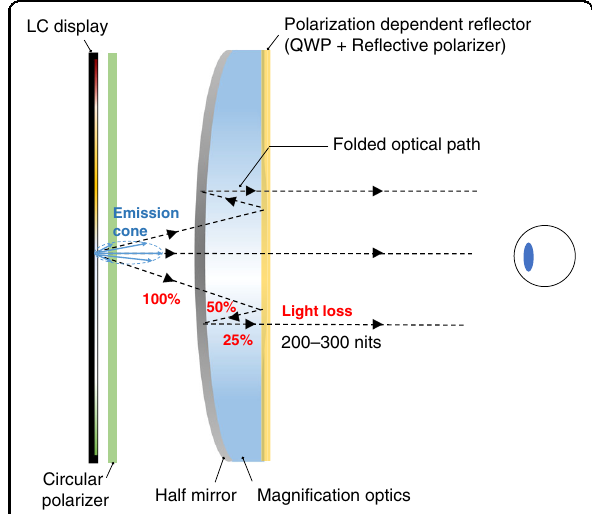
Fig. 2 The VR systems based on pancake optics typically consist of a display panel, circular polarizer, half mirror, magnifying lens, quarter-wave plate, and re fl ective polarizer. Light from the display panel has a folded optical path to reduce the system thickness, which in turn helps improve the center of gravity of the VR